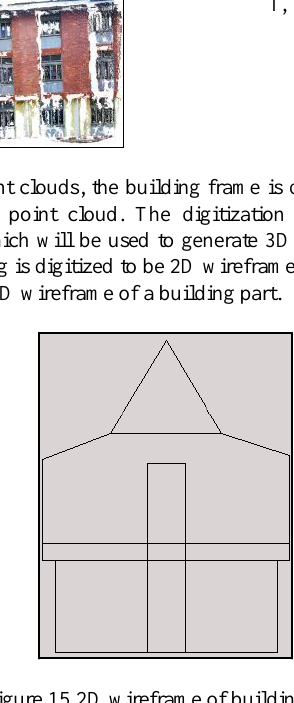
Figure 15 2D wireframe of building part